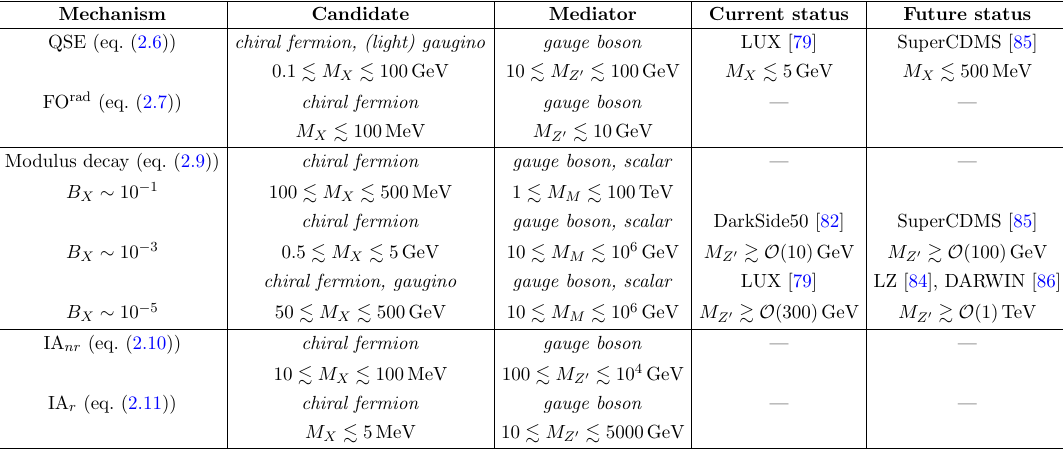
Table 2. Table summarising the various relic density production mechanisms, as discussed in section 2, and the current allowed parameter space, as discussed in section 4. The kinetic mixing parameter has been set to (cid:15) = 10 (cid:0) 3